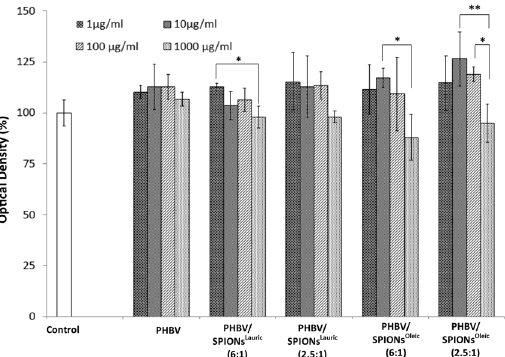
Figure 11. Cell viability of MEF cells in contact with extracts from PHBV-based microspheres at concentrations of 1 μ g/ml, 10 μ g/ml, 100 μ g/ml and 1000 μ g/ml after 24 hours incubation time. Asterisks denote significant difference, * p < 0.05 and ** p < 0.01 (Bonferroni’s post-hoc test was